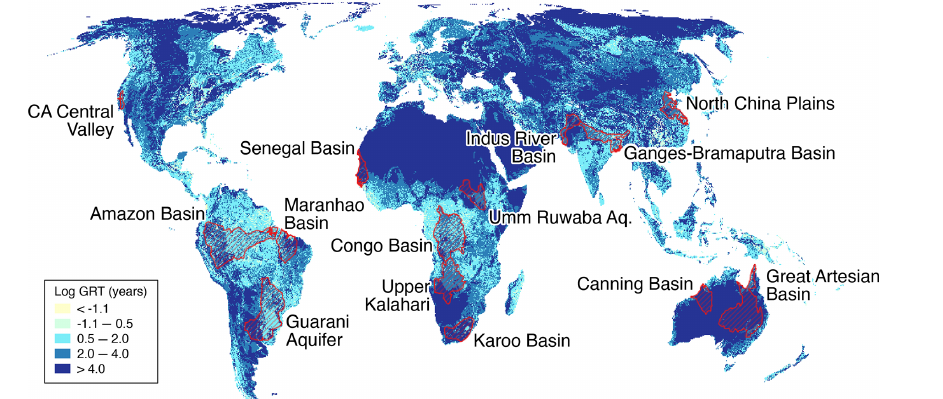
Figure 4. The 14 selected world large-scale aquifers (the study aquifers) overlaid on the GRT dataset (original dataset from Cuthbert et al.,